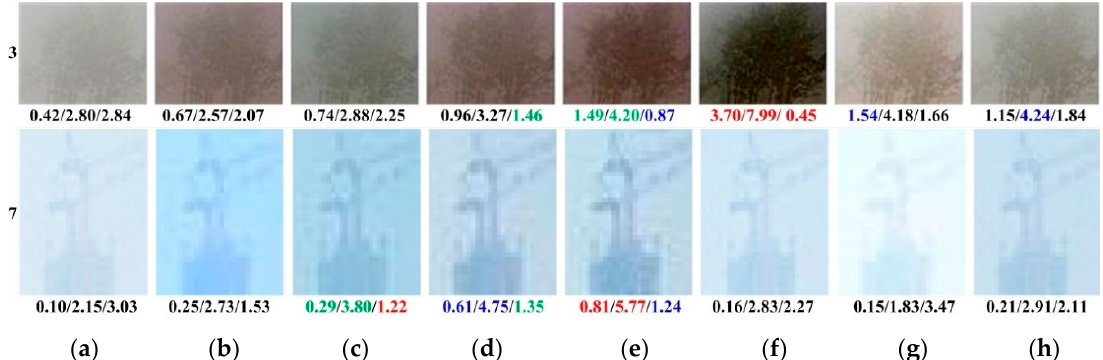
Figure 7. Local areas from red boxes in images nos. 3 and 7 in Figure 6 with local AG, IE, and FADE values listed below each image. The 1st, 2nd, and 3rd winners of each measurement are displayed in red, blue, and green colors, respectively. ( a ) Hazy Inputs. ( b ) DehazeNet [6]. ( c ) AOD [8]. ( d ) CAP [2]. ( e ) PDN [10]. ( f ) GDN [11]. ( g ) F-DCP [15]. ( h ) TGL-Net-Mix.